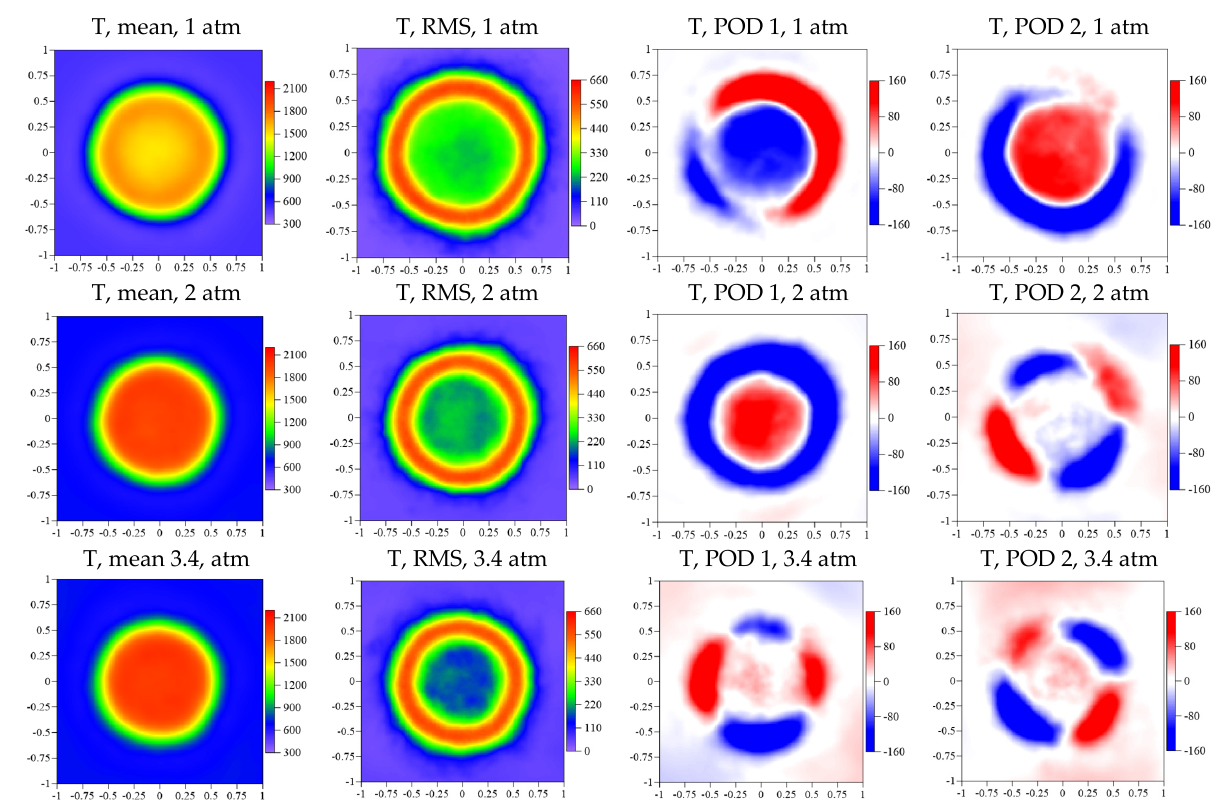
Figure 18. Mean and variations in the temperature field and the first and the second POD modes.